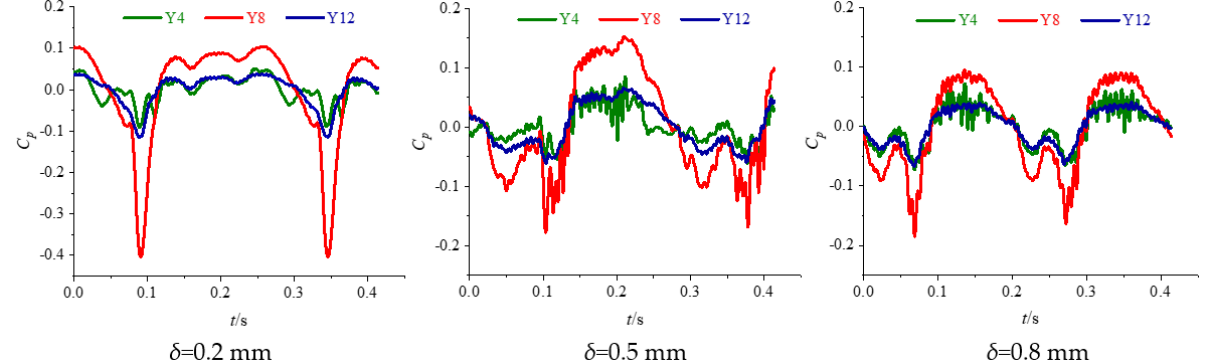
Figure 22. Time domain diagram of pressure fluctuation at impeller outlet monitoring point (Y4, Y8,